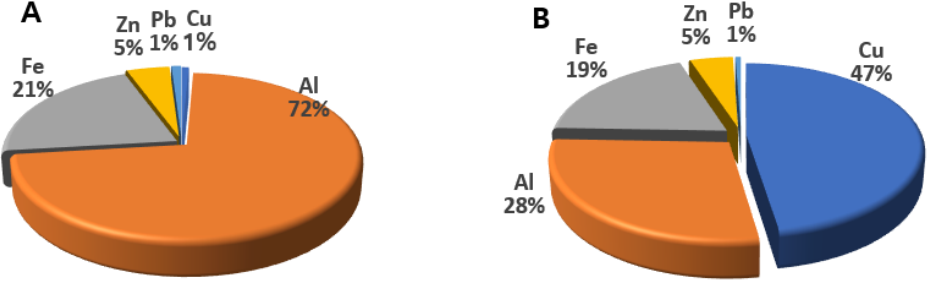
Figure 2. Proportion of metals in PM2.5 ( A ) and TSP ( B ).